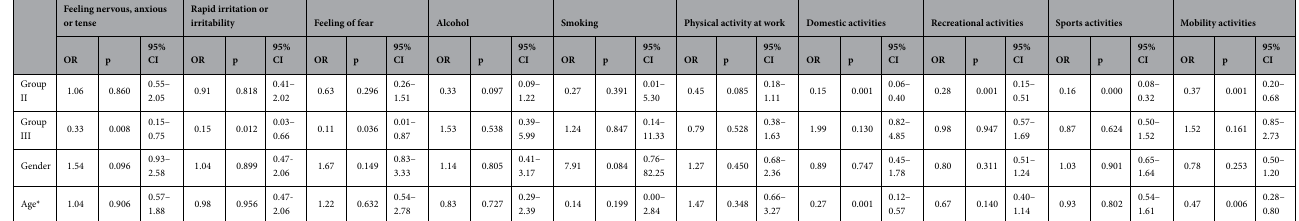
Table 10. Multivariate analysis of variables (Group I as comparison group). *As binary value ≤ 60 years old and > 60 years old. # Statistically significant values ( p <